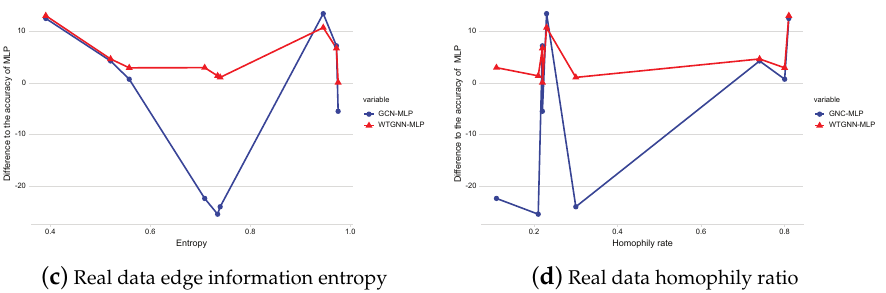
Figure 4. The impact of entropy and heterophily on the performance of GNNs on synthetic datasets and real-world